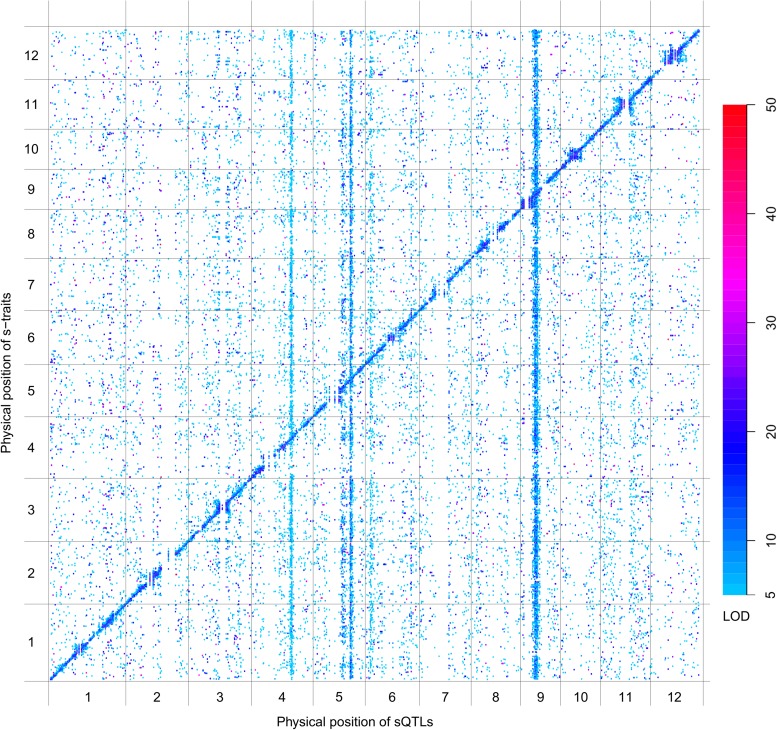
sQTLs for the 66,649 s-traits.The color key shows the LOD value. X-axis, the physical position of sQTLs along the genome of 12 chromosomes. Y-axis, the physical position of s-traits. QTLs with LOD value <5 are not included in the presentation.